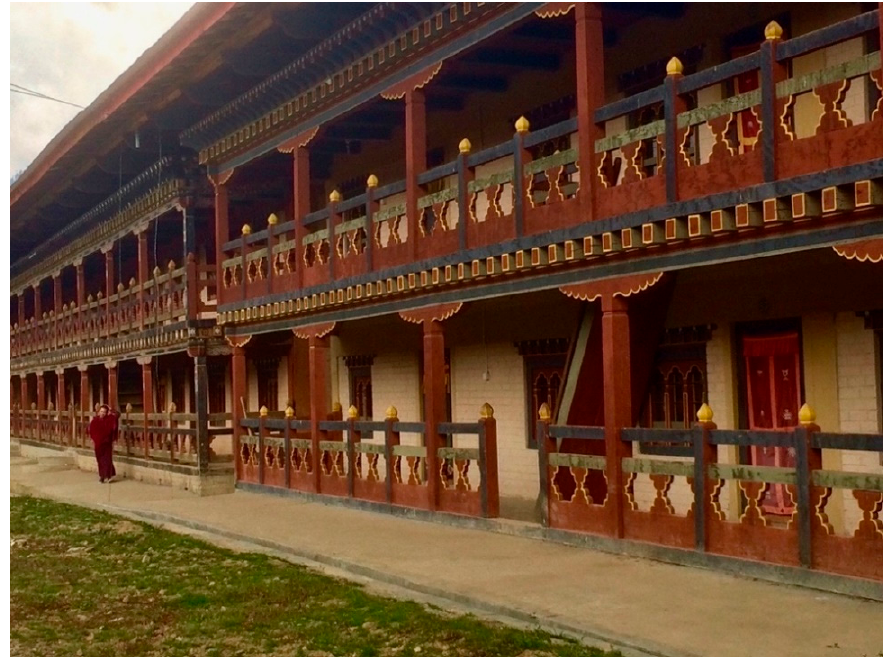
Figure 4. A view of the monk’s quarters at Gangteng Monastery in the Phobjika Valley, Bhutan. Image by Shin Yu Pai.